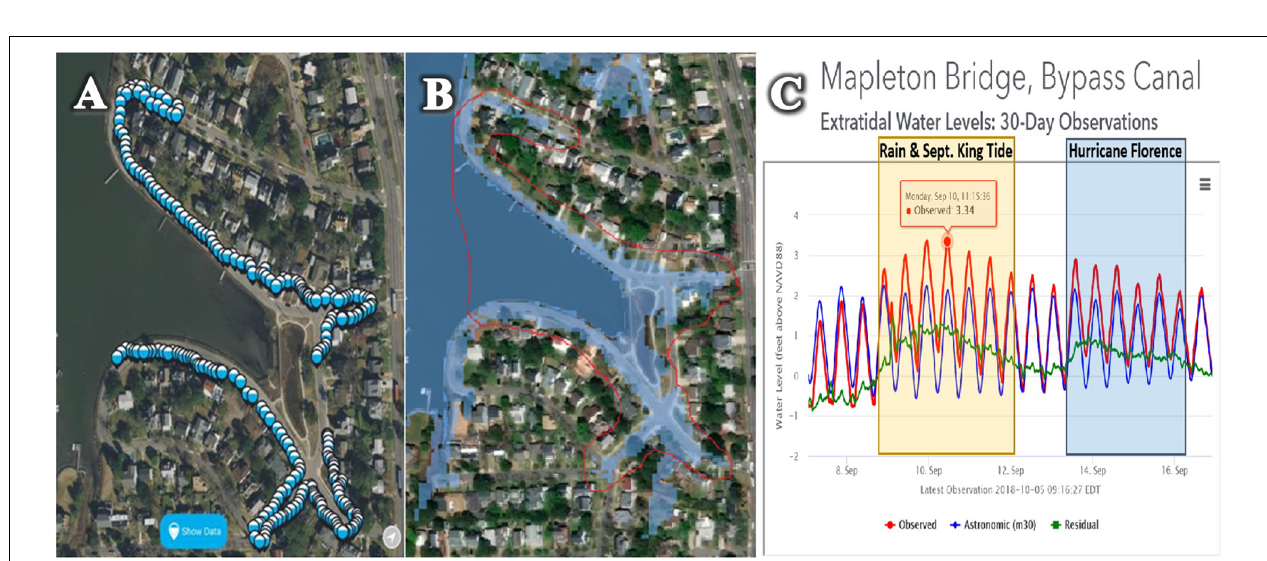
FIGURE 6 | (A) Web map of king tide inundation extent data collection on 11/5/2017. http://arcg.is/1HLOPS. (B) Inset: zoom of Norfolk’s historic Hague depicting a zoomed map of the area with dense patches of volunteer-observed flood extents noted with timestamped blue dots, and model-predicted tidal flood extents in light blue. (C) Student scientists photograph flood gauges during tidal inundation events and scan a QR code to upload their images via a geoform or the Sea Level Rise App to aid in validating flood depths. Photo credit: Derek Loftis.